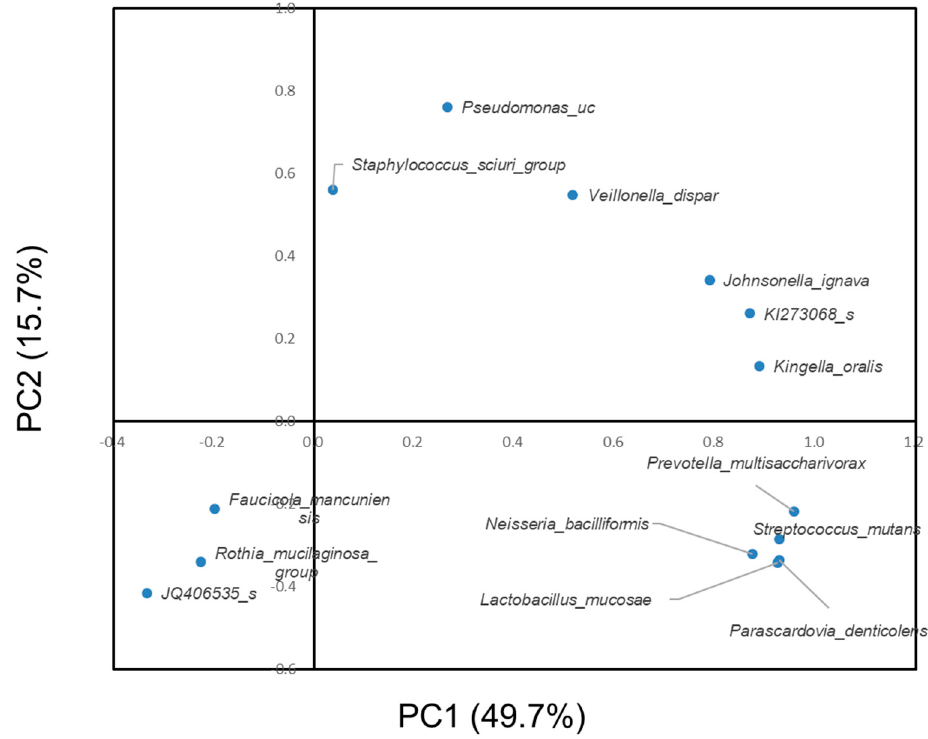
Figure 4. Principal component analysis of the significantly di ff erent bacteria between subjects with or without dental caries at the species level.